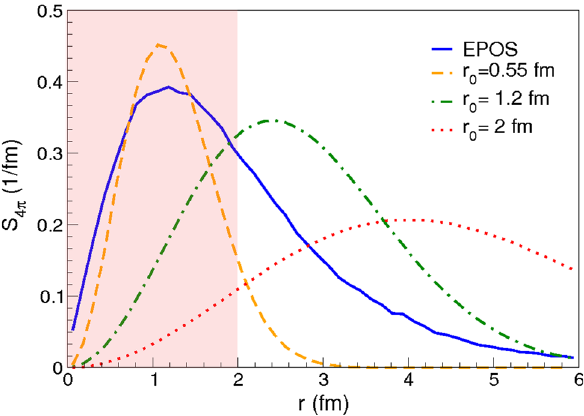
Fig. 1 The probability density function of the relative distance r for p–p pairs produced in pp collisions at 7 TeV. The blue solid line is the prediction from the EPOS transport model, the dashed orange line, the green dot-dashed line and the dotted red line are Gaussian sources with different radii. For better visibility the source with r 0 = 0 . 55 fm is scaled down by 0.6. The red shaded area shows the typical range of the strong interaction where an approximate solution to the Schrödinger equation may